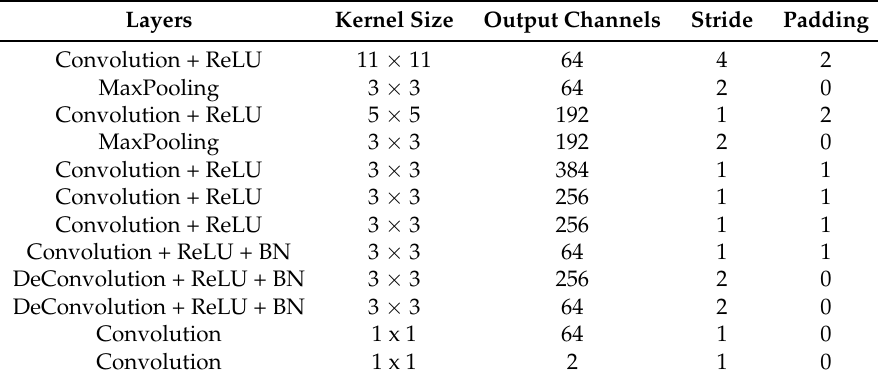
Table 1. Architecture details for the proposed network.